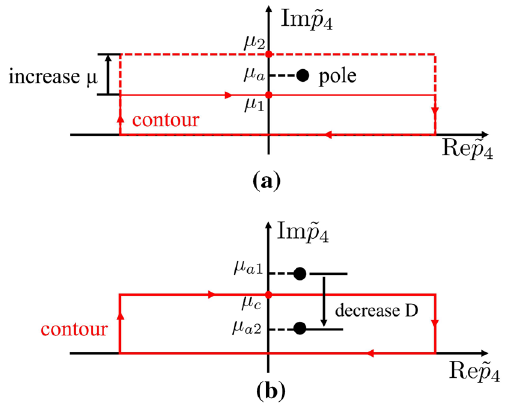
Fig. 1 Schematic feature of the contour and the singularities. Upper panel: by increasing the chemical potential, the contour may include the pole, and the number density becomes nonzero. Lower panel: for a fixed chemical potential, by decreasing the coupling constant D , the imaginary part of the pole becomes small and moves inside the contour, and the number density becomes